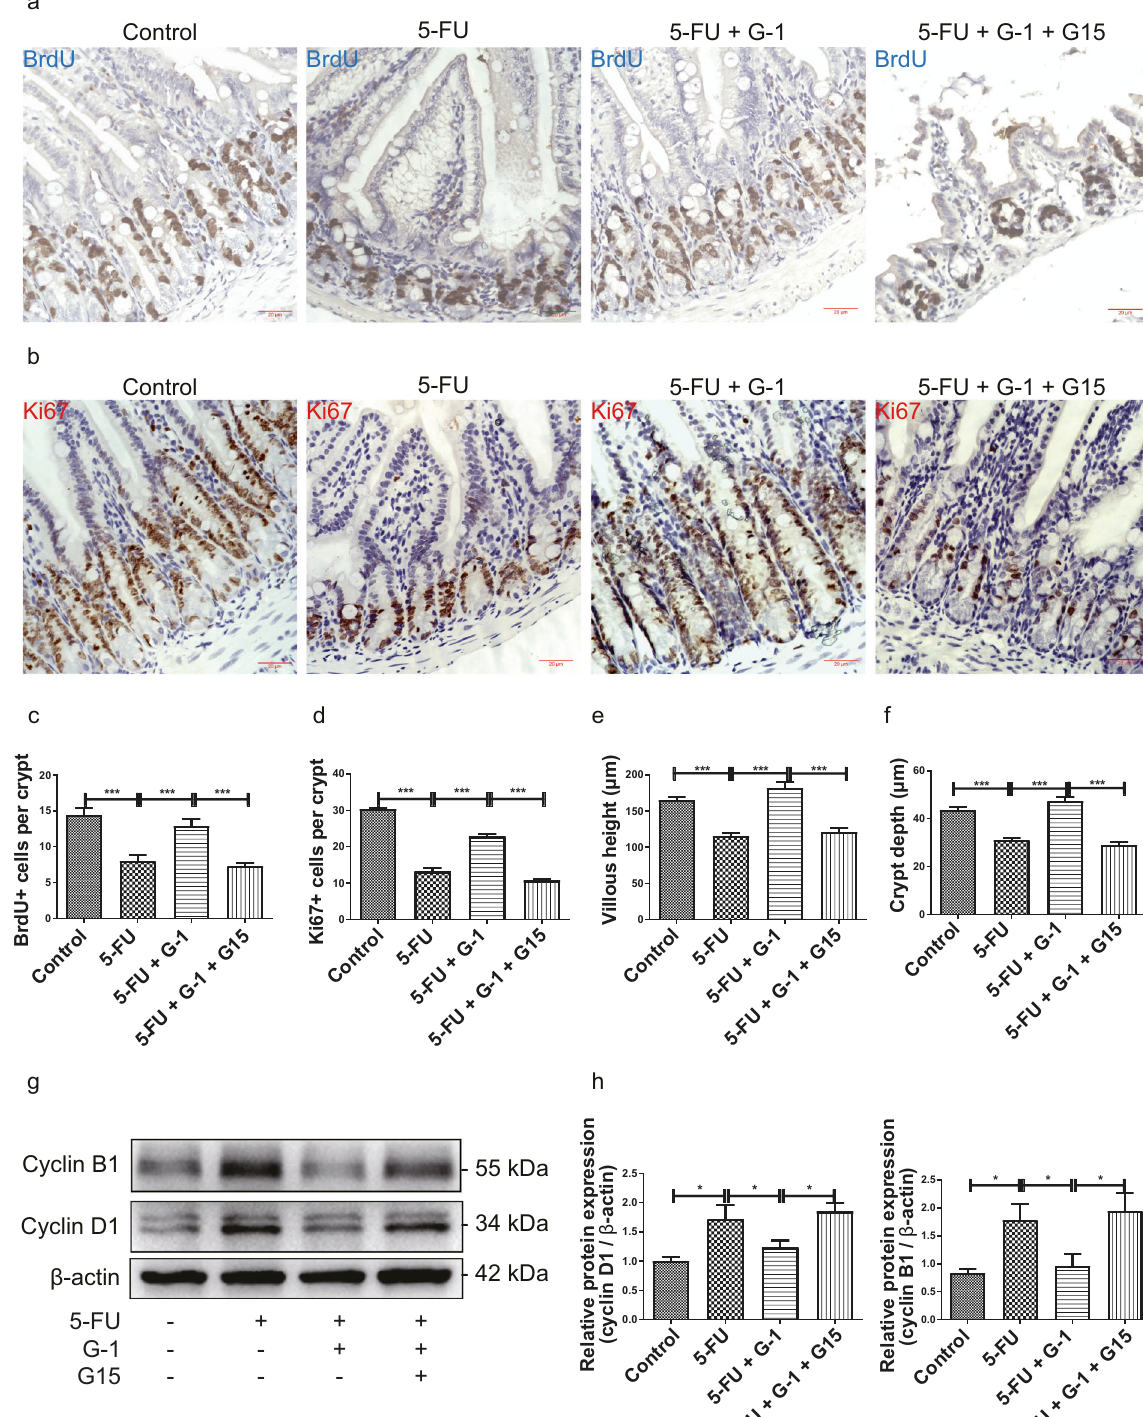
that the G-1 and PD0325901 combination treatment caused the weight loss to be more serious in the CIM model (Fig. 8e), this effect might be related to other mechanisms that were not studied here. In addition, PD0325901 completely blocked the effect of G-1 treatment on the number of Muc-2 + cells in the CIM model (Fig. 8j). PD0325901 alone did not further exaggerated the inhibition of p-ERK1/2 activities in CIM, so did the abnormal performances in CIM (Fig. S3, Fig. 8c –